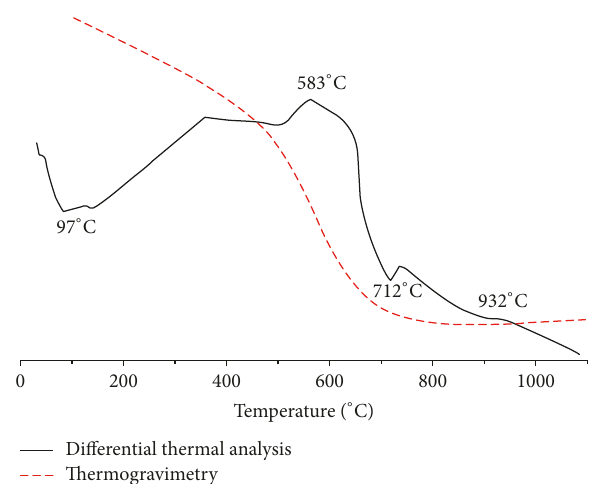
Figure 3: The DTA and TG results of the Vladivostok TPP fly ash